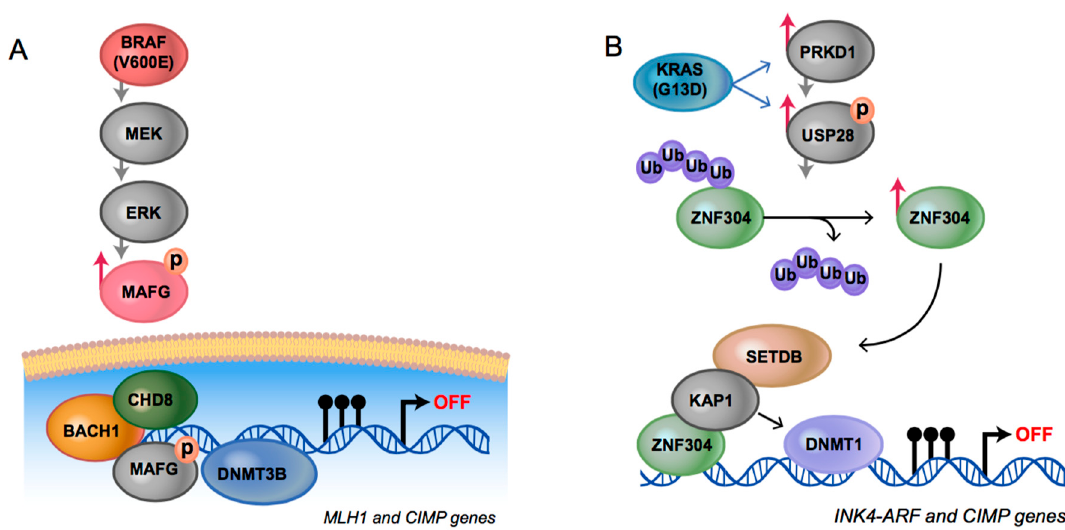
Figure 1. Mechanisms establishing CpG island methylator phenotype (CIMP) in colorectal cancer: ( A ) Model reproduced from [24] with permission from Elsevier; protein kinase B-Raf (BRAF) V600E increases MAPK/ERK kinase (MEK)/extracellular signal-regulated kinase (ERK) signaling and causes levels of MAF BZIP transcription factor G (MAFG) to increase via phosphorylation, which protects it from polyubiquitination and subsequent degradation via the proteasome. MAFG directs a transcriptional repression complex that includes the DNA methyl transferase DNMT3B to CIMP-associated genomic loci; ( B ) Model reproduced from [25] published by eLife Sciences